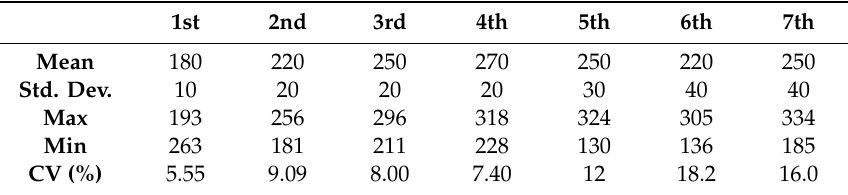
Table 11. Statistics on 7-day demand profiles